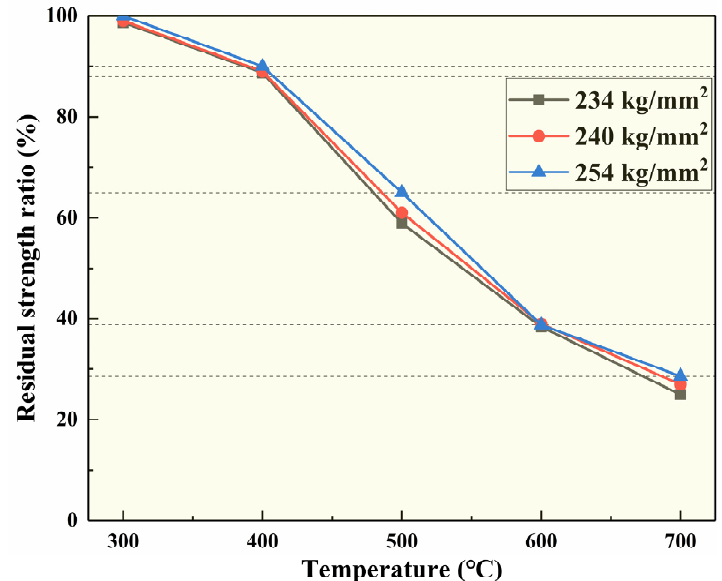
Figure 5. Residual strength ratio of BF fabric at different temperatures